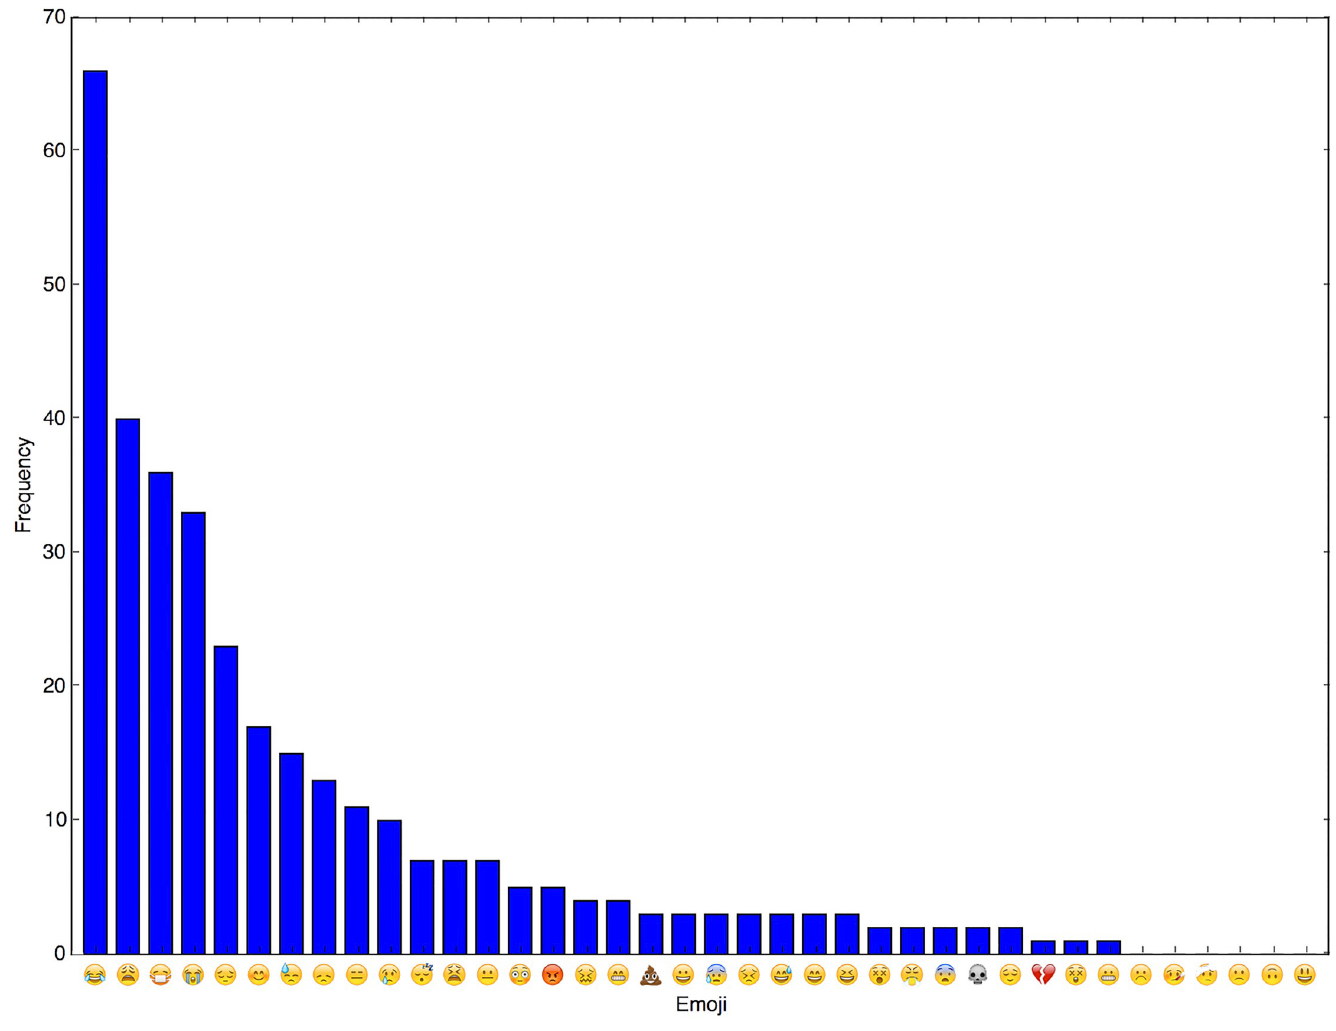
Fig 4. Bar chart showing emoji frequency in labelled